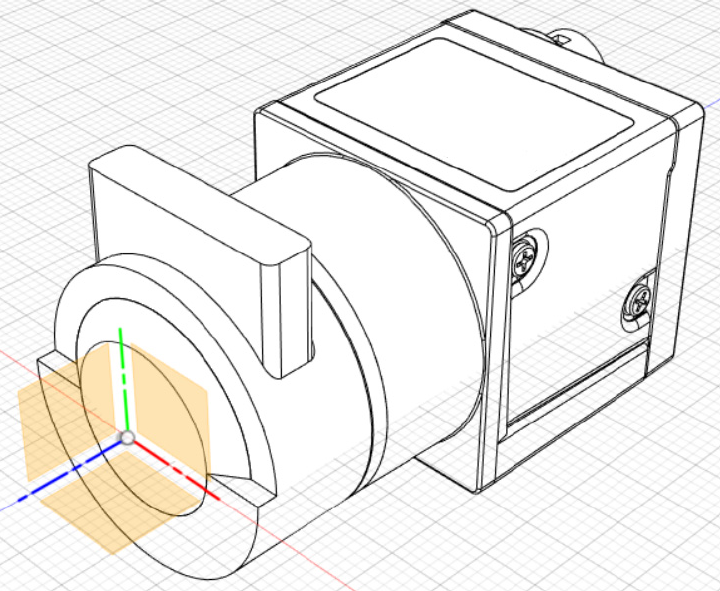
Figure 21. 3D design of an eye model prototype using the software Autodesk Fusion 360 © 2020 Autodesk, Inc. (version 2.0.12670, student license, sourced in Lisbon, Portugal). The axes’ origins are placed at the center of the anterior surface of the cornea, coinciding with the optical axis.